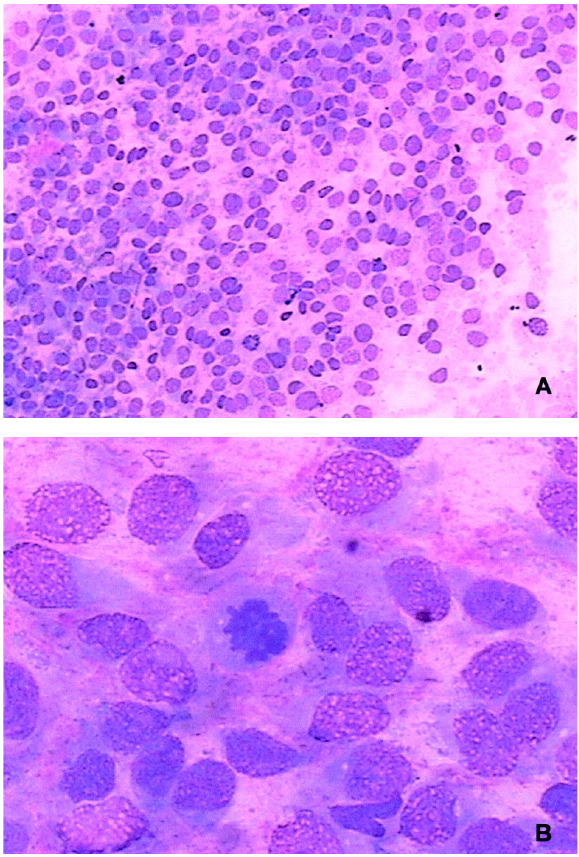
Figure 2 – Smears obtained by fine needle aspiration puncture. A) - Abundant scattered small round cells. B) - Detail of tumor cells with ovoid nuclei, scarce cytoplasm and mitotic figure (Gi- emsa, X33 and X132,